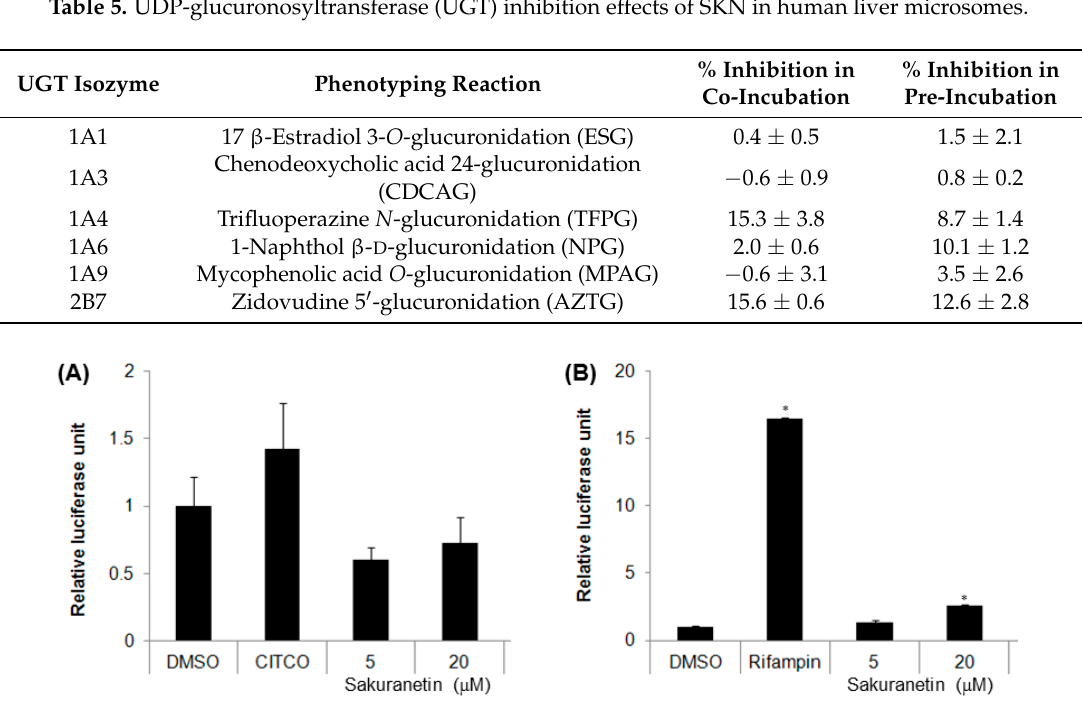
Figure 4. Transactivation of CAR-mediated CYP2B6 ( A ) and PXR-mediated CYP3A4 ( B ) promoter luciferase genes by SKN in HepG2 cells. The expression plasmids coding either hCAR or hPXR were co-transfected into confluent HepG2 cells, along with either the CYP2B6 or CYP3A4-luciferase plasmids. Transfected cells were treated with the appropriate compounds, and luciferase assays were performed. Data are reported as relative luciferase activity unit (RLU: firefly luciferase reading divided by Renilla luciferase reading). Differences among luciferase activities from various treatment groups versus the dimethylsulfoxide (DMSO)-treated group were determined using Student’s t -test. An asterisk indicates p < 0.001.